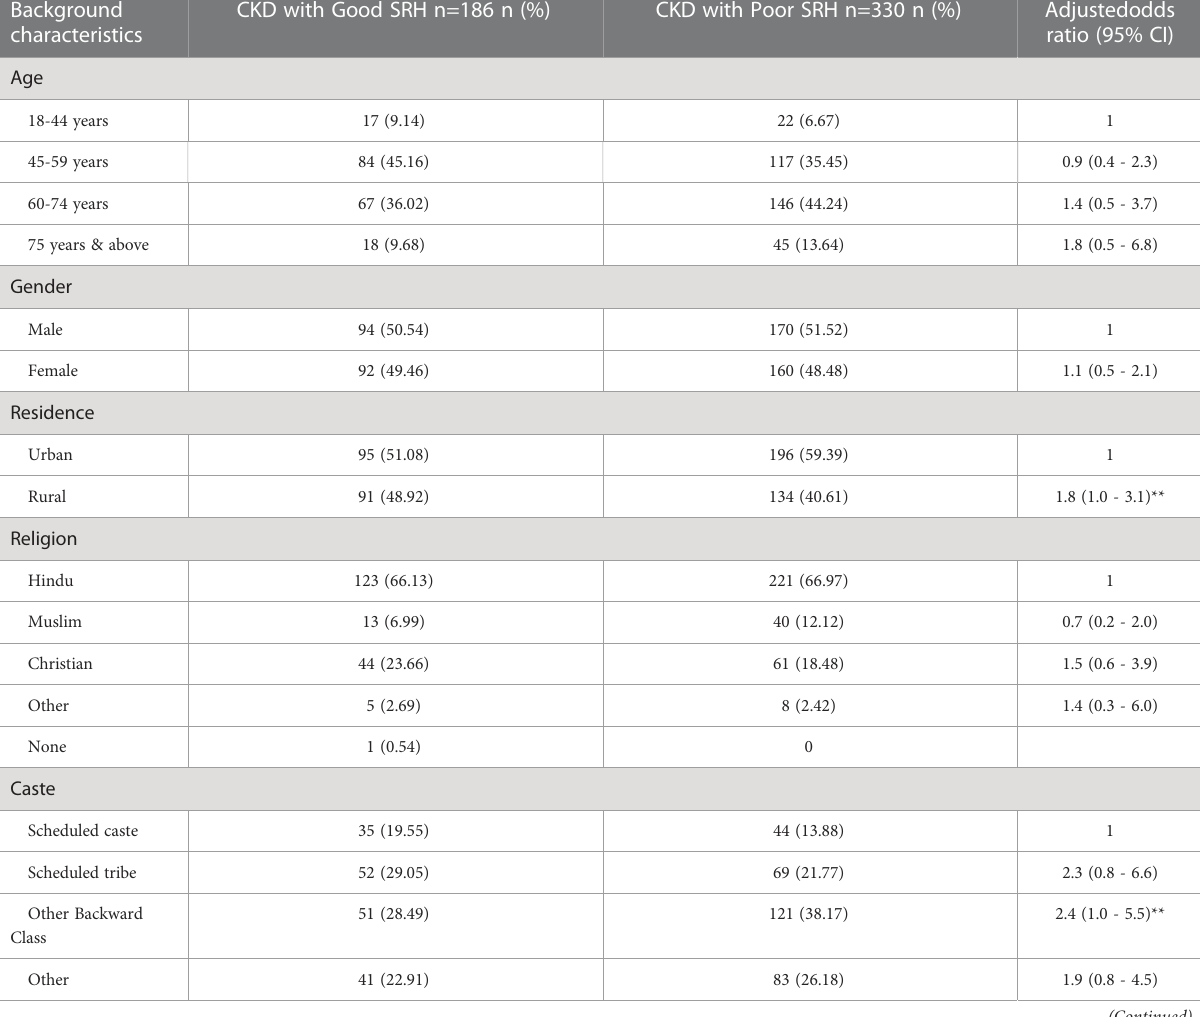
TABLE 2 Multivariable logistic regression model of self-rated health and CKD patients with their background characteristics. Background